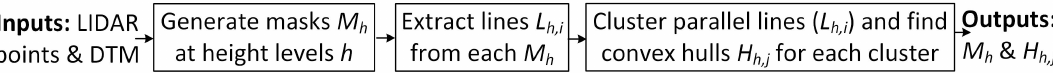
Figure 3. The work flow for generating masks and convex